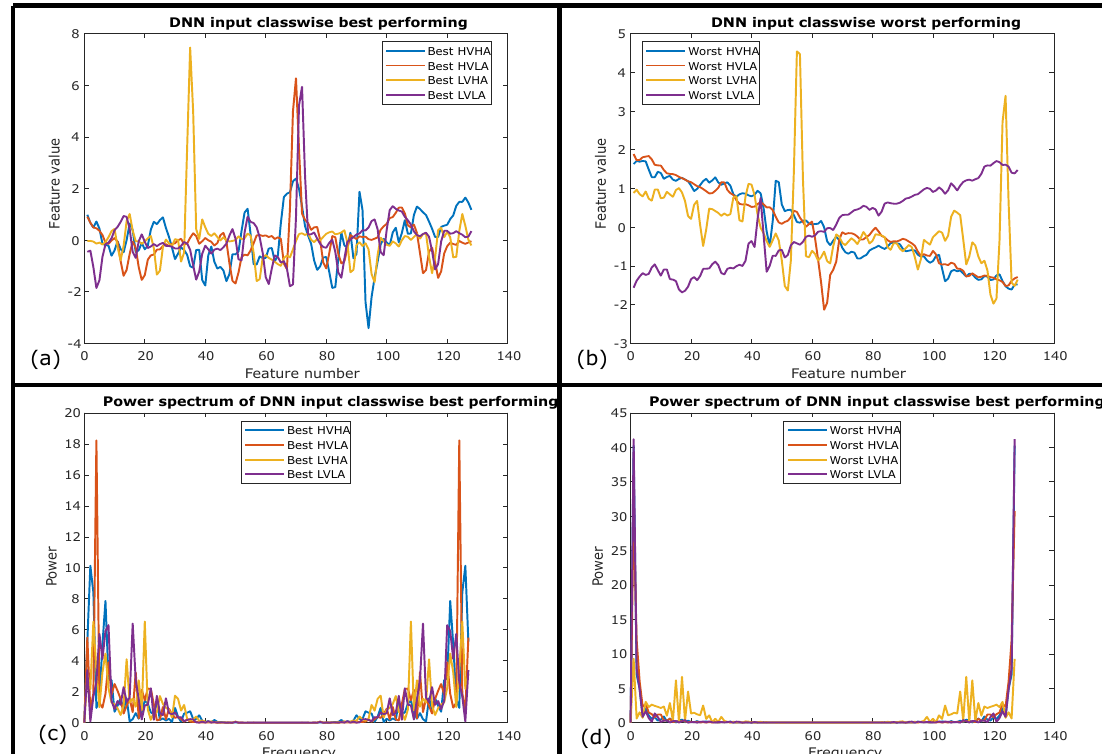
Figure 8. ( a ) Best-performing class-wise ECG samples. ( b ) Worst-performing class-wise ECG samples. ( c ) Spectrum of best-performing class-wise ECG samples. ( d ) Spectrum of worst-performing class-wise ECG